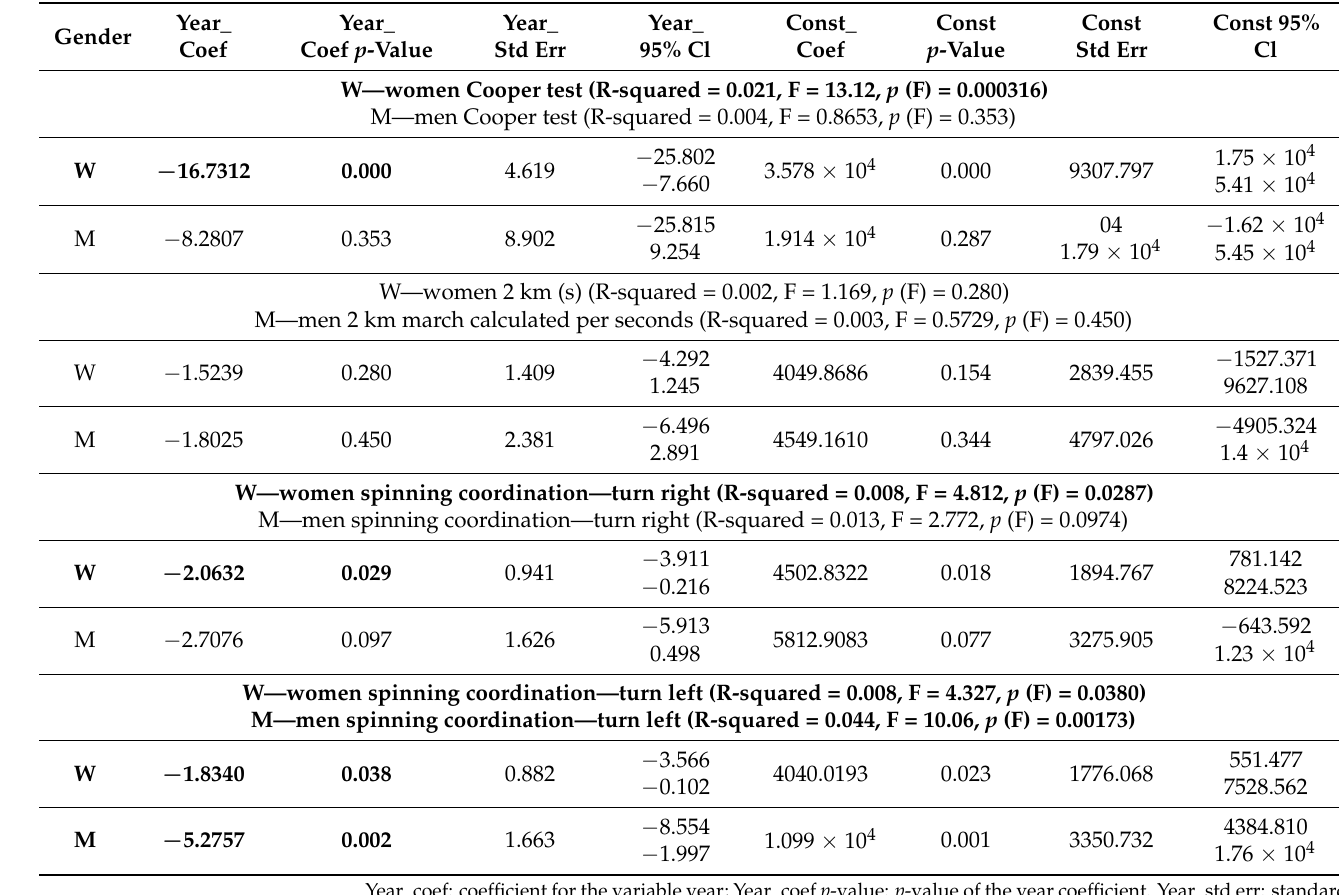
Table 7. Table 7. The results of the analysis of temporal changes in the examined motor traits in the